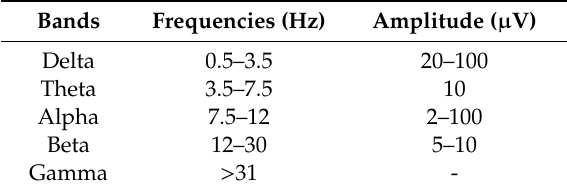
Table 1. Frequency and amplitude range of the EEG